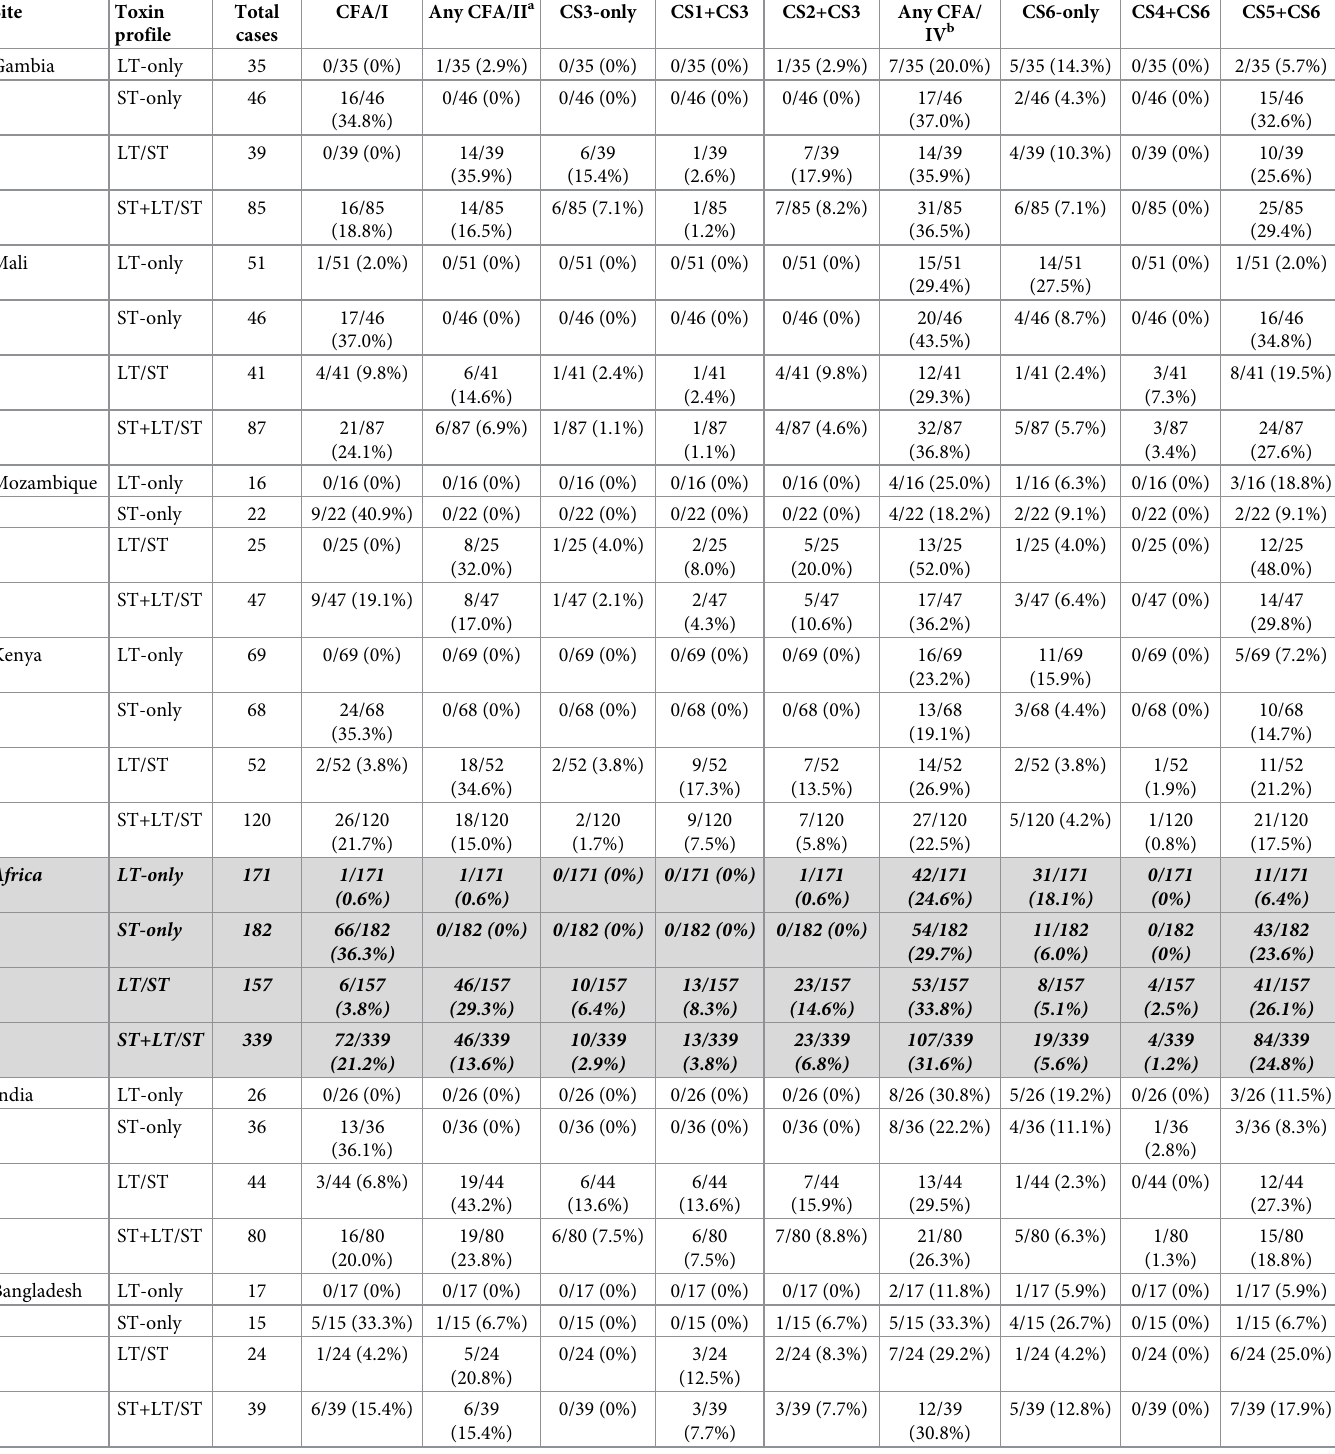
Table 3. The prevalence of major colonization factors that are contained in leading vaccine candidates, by toxin profiles, among ETEC strains from 806 MSD cases from individual GEMS sites in Africa and Asia.